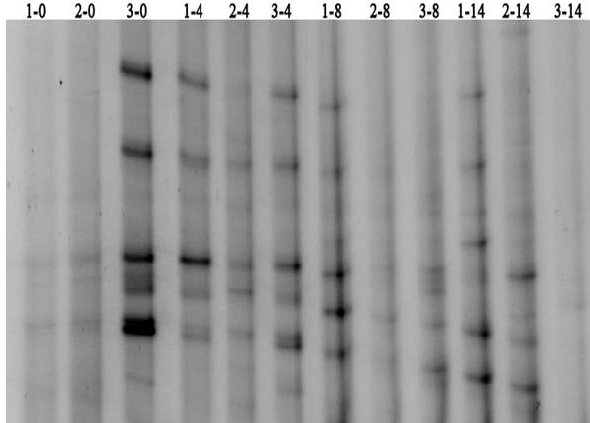
Figure 5: DGGE profiles of amplified 16S rDNA fragments (bacteria) from different size aggregates during the incubation. Experiment treatments are designated by 1, 2 and 3 before the hyphen“-”for <0.5mm, 1-2mm, and 2-3mm soil aggregates, respectively. The numbers flowing the hyphen“-”refer to the sampling days.